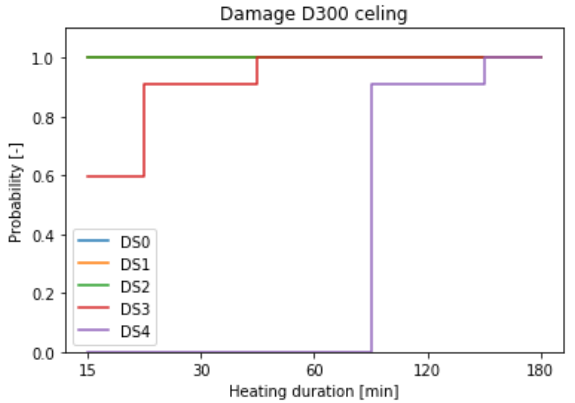
Figure 9. Structural damage state probabilities (probability of damage class DSx or higher) for unpro- tected tunnel ceiling in function of RWS heating phase duration. Note that the damage class is evaluated for the heating durations 15/30/60/120/180 minutes